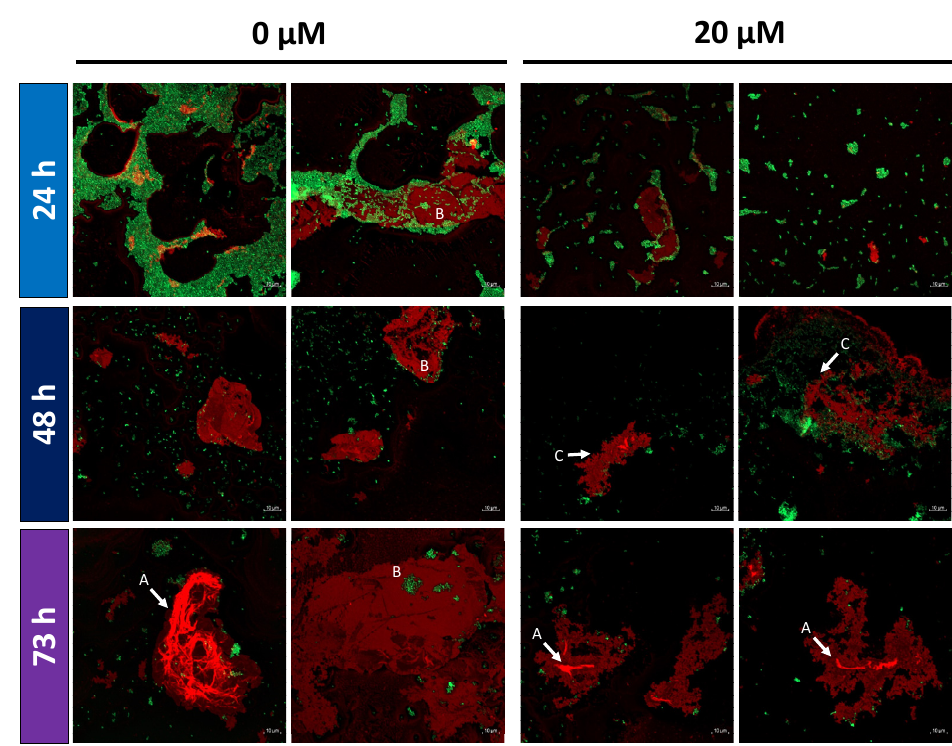
Figure 7. Fluorescence microscopy of Prevotella bryantii B 1 4 cells at 24, 48 and 73 h of cultivation with 0 and 20 µM monensin. Fluorescence stain of EPS (red, Alexa Fluor 594) and DNA (green, SYTO 9). Each condition is presented in duplicates. Lower right corner indicates a size reference of 10 µM. Capital letters point at dense EPS regions ( A ), cells embedded in EPS ( B ) and at fringed edges of EPS layer ( C ).